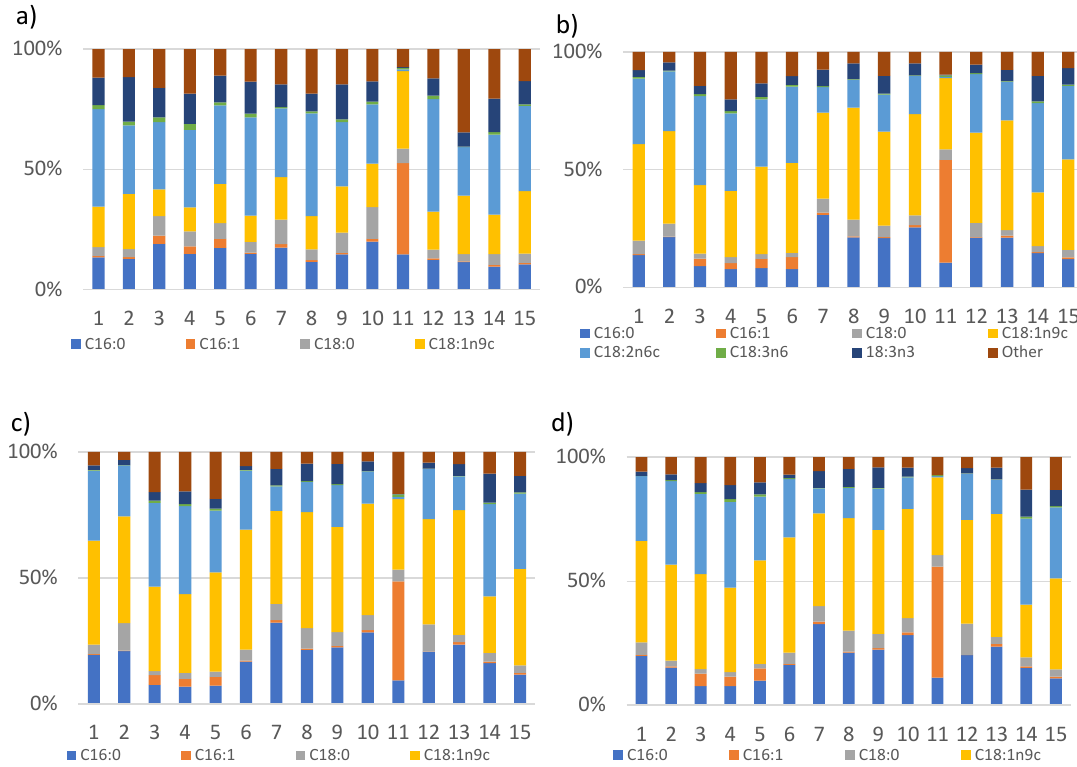
Figure 3. Fatty acid profile of TAGs accumulated in yeast grown in the media with (a) C/N 10:1, (b) C/N 40:1, (c) 70:1, (d) C/N 100:1 ratio.